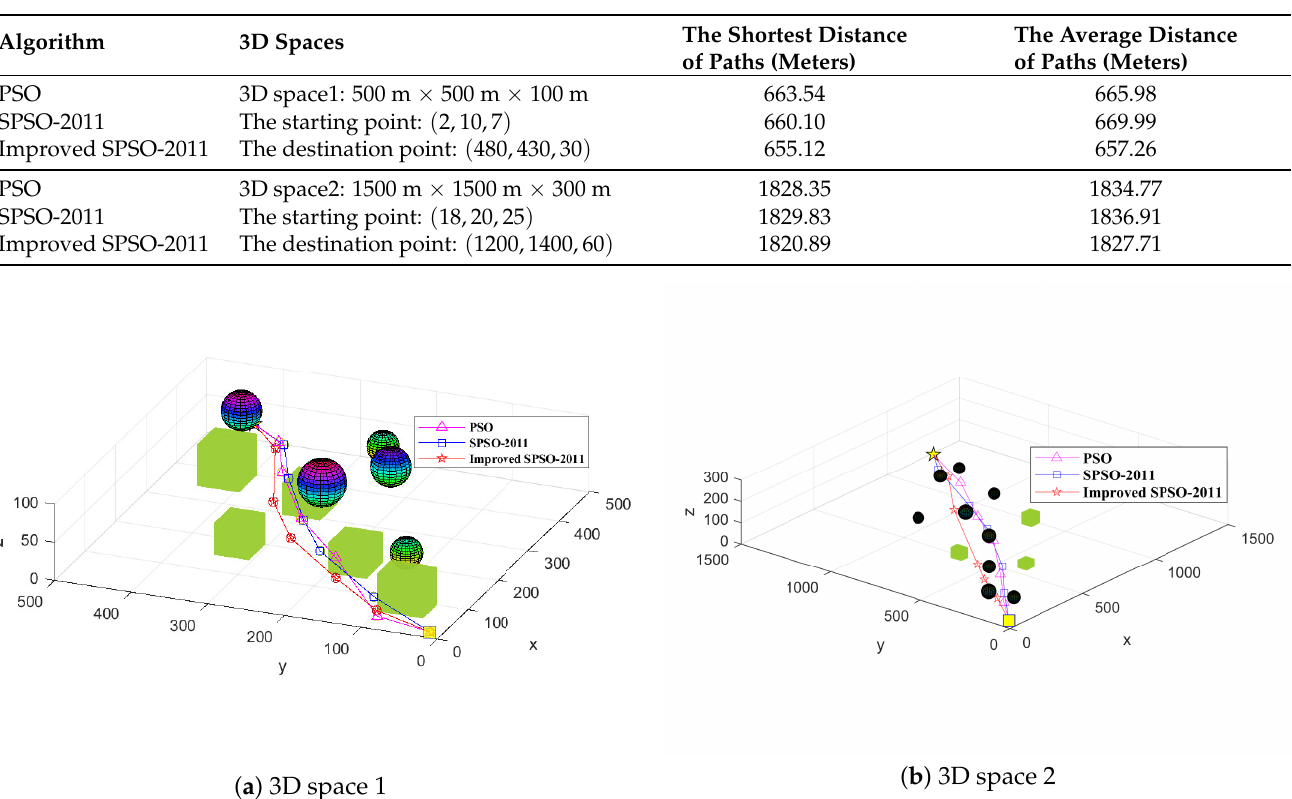
Figure 5. Compared with the optimal path of three path planning